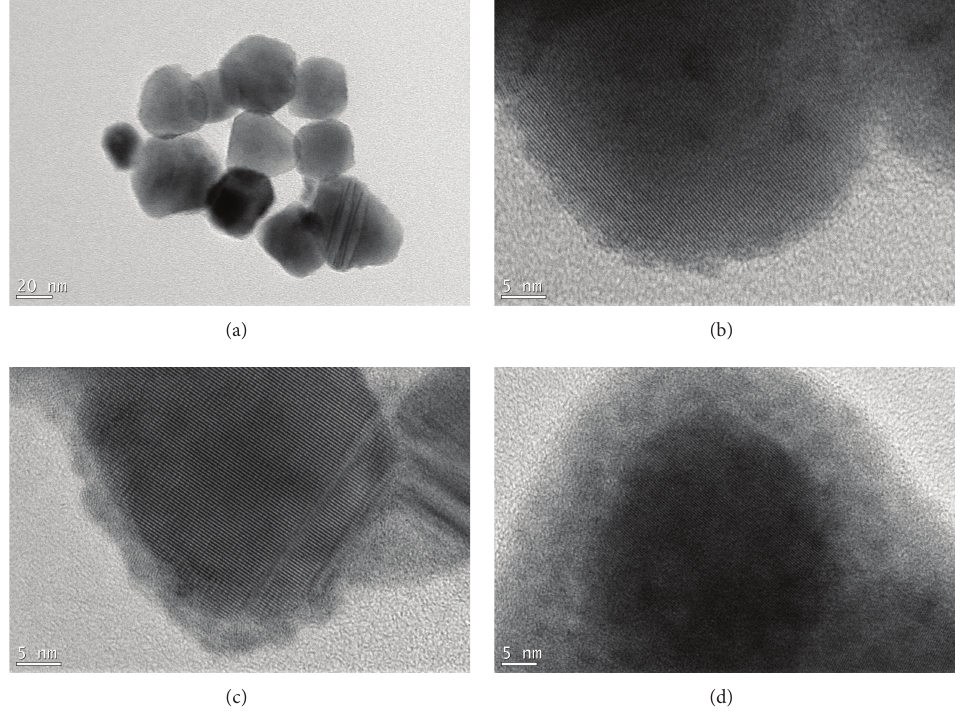
Figure 6: TEM image of (a and b) CdS, (c) PdS/CdS prepared by in situ coprecipitation, and (d) PdS/CdS prepared by hydrothermal method at 160 ∘